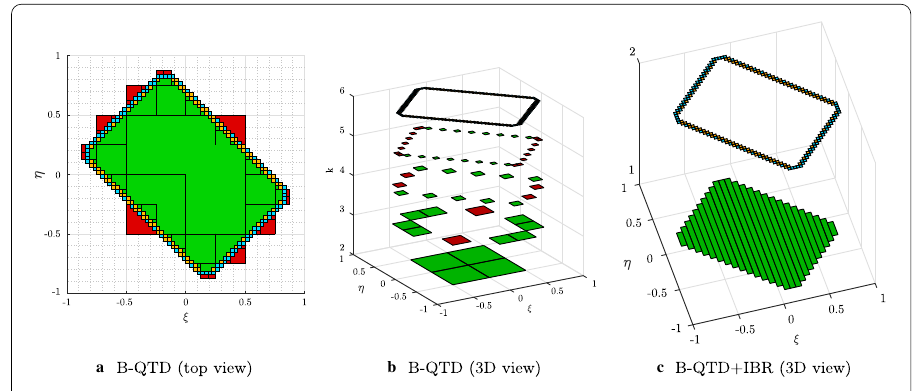
Fig. 18 Compression of the sub-cells resulting from the B-QTD, based on the procedure depicted in Fig. 17. For the given example the IBR compression technique was used